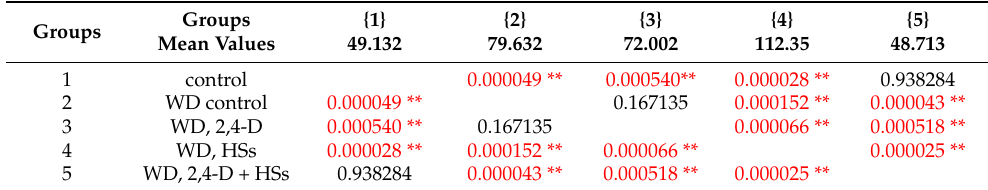
Table 11. ANOVA test for root cytokinins content followed by Duncan test. Values in the cells correspond to p for the difference between the mean values; p ≤ 0.05 is marked with *; p ≤ 0.01—with ** for control plants untreated with either bacteria or HSs and plants grown under water deficit (WD): control, plants treated with Pseudomonas plecoglossicida 2,4-D (2,4-D), humic substances (HSs) and their combinations (2,4-D +